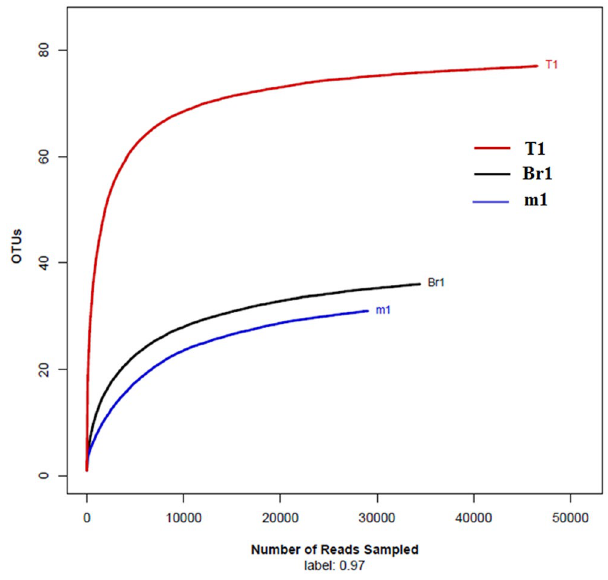
Figure 1. Rarefaction curves of the OTU number in a 97% similarity boxplot for each sample. T1, Br1 and m1 are shorts for the midgut samples of Plutella xylostella , from field-caught population, deltamethrin-resistant population and deltamethrin-susceptible population, respectively.